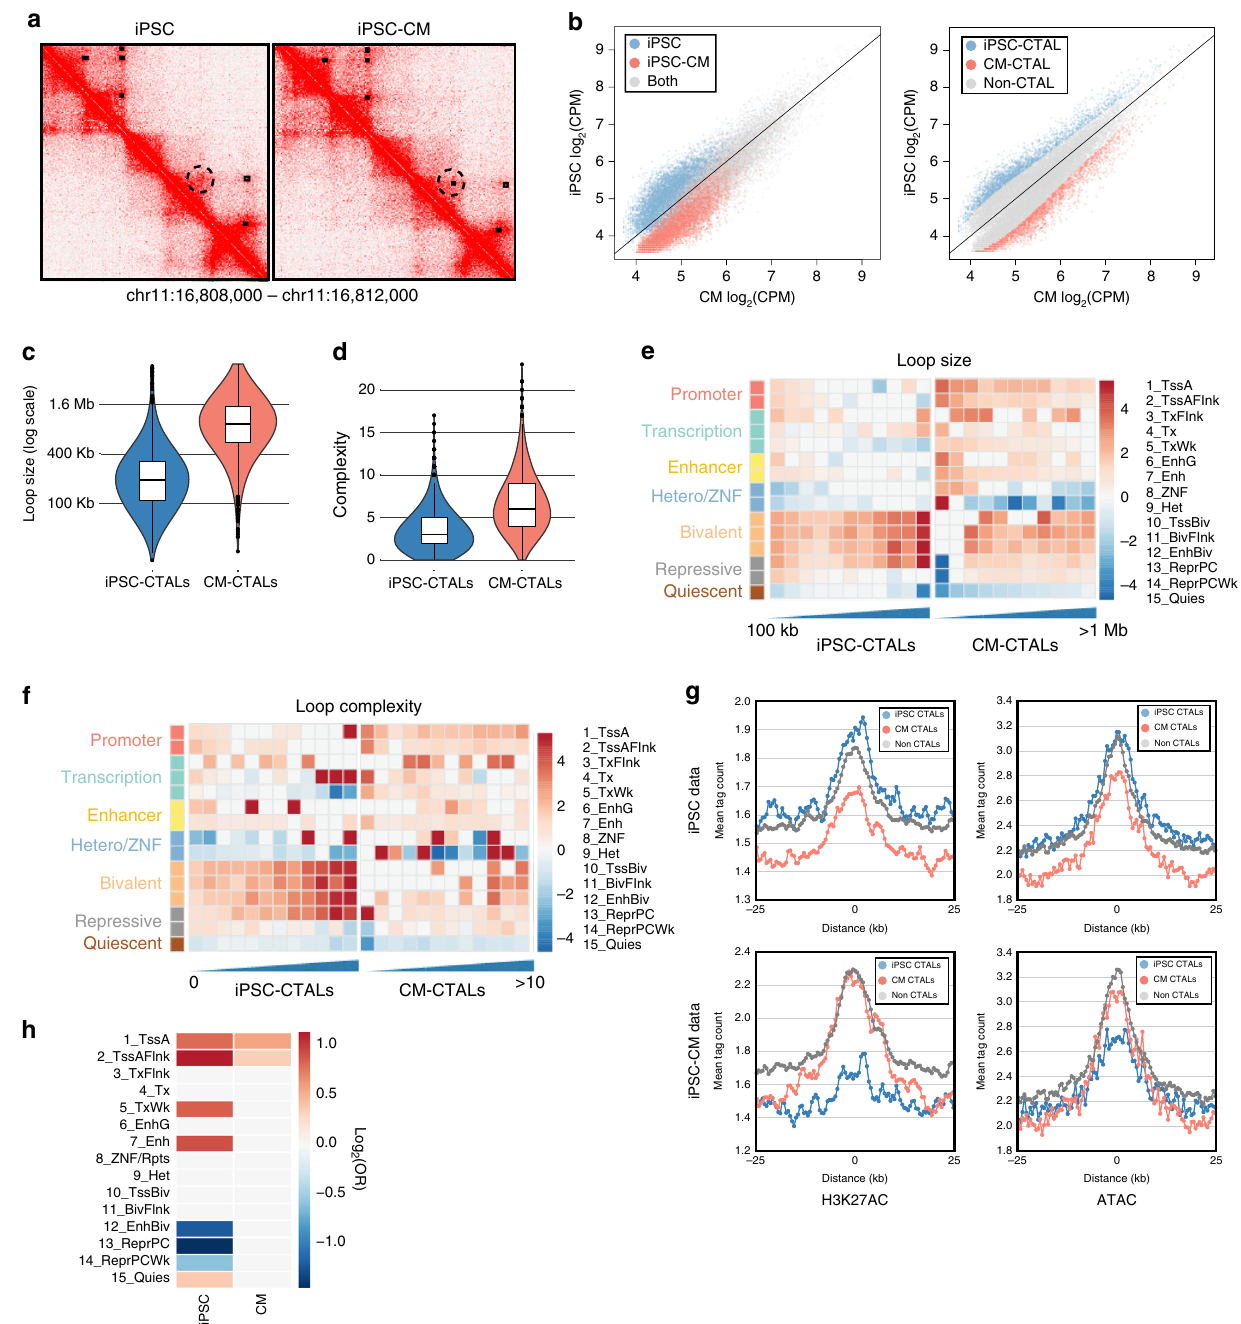
Fig. 3 Differential chromatin states and sizes in CTALs recapitulate changes in looping across differentiation. a Example contact maps showing a loop which appeared in both cell types but was only called in one cell type. Loop calls are shown in the top right half of the contact map as black rectangles. A dotted circle has been added to highlight the region which appears the same in both cell types, but only has a loop call within iPSC-CMs. b Scatterplots showing contact frequency in counts per million (CPM) of all loops identi fi ed in either iPSCs or iPSC-CMs. The solid black lines indicate the function y = x . (left) Points are colored to indicate loops called in only iPSC (blue), only iPSC-CM (red), or both (gray). (right) Points are colored to indicate loops with signi fi cantly increased contact frequency in iPSCs (iPSC-CTAL; blue), iPSC-CMs (CM-CTAL; red), or neither (non-CTAL; gray). c , d Violin plots (all four quartiles shown via lower whisker, lower half of box, upper half of box, and upper whisker; lines indicate median) showing distributions of c loop size, and d loop complexity for CTALs. e , f Heatmap showing enrichment of regulatory regions near iPSC-CTAL (left) and CM-CTAL (right) at loop anchor centers with loops strati fi ed by e size or f complexity. The 15 ROADMAP chromatin states of iPSC (E020) or fetal-heart tissue (E083) were used, and the log 2 odds ratio of enrichment is indicated by color (red positive, blue negative). CTALs broken down by size into e 100 kb windows, or f complexity. g Line plots showing the mean tag intensity of H3K27AC (left) or ATAC-seq data (left) from iPSC (top) or iPSC-CMs (bottom) at iPSC-CTAL (blue), CM-CTAL (red), or non-CTAL (gray) anchors. Cell type data is enriched at cell type CTAL anchors, and non-CTAL anchors, whereas non-cell type data is depleted at cell type CTAL anchors. h Heatmap of log 2 (odds ratio) from a Fisher ’ s exact tests for enrichments of differential chromatin states across CTAL anchors. White cells indicate a non-signi fi cant Fisher ’ s exact test (FDR q > 0.05). log 2 (OR) is shown by color (red positive, blue